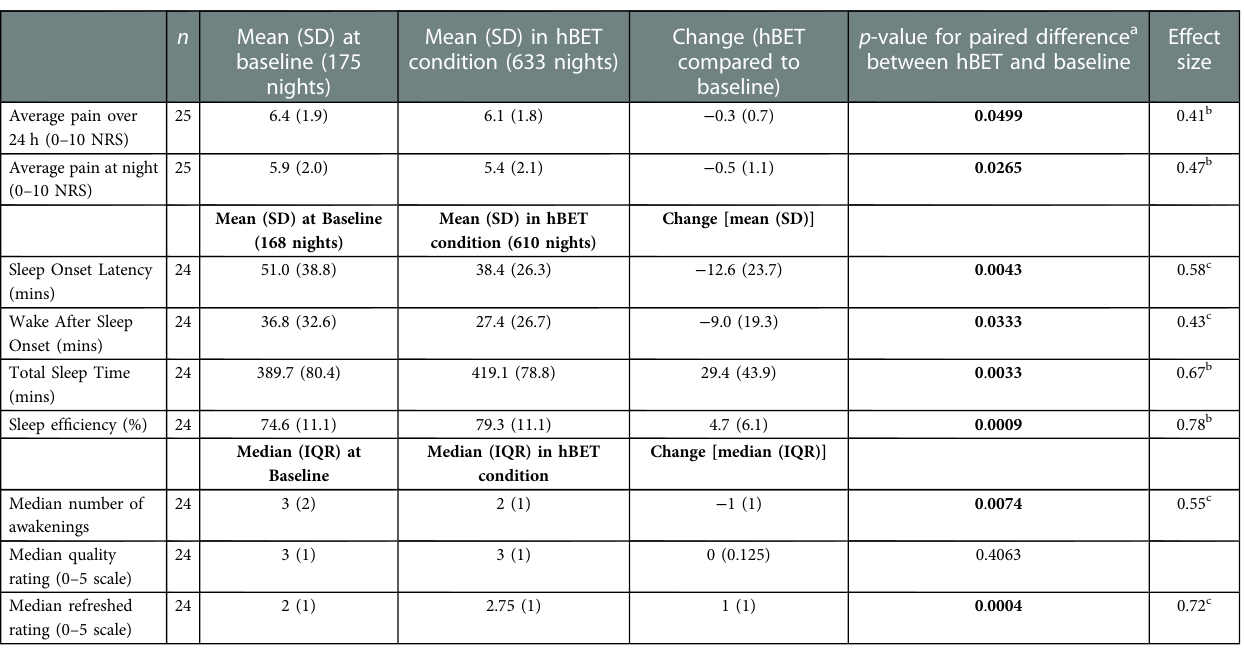
TABLE 2 Sleep diary